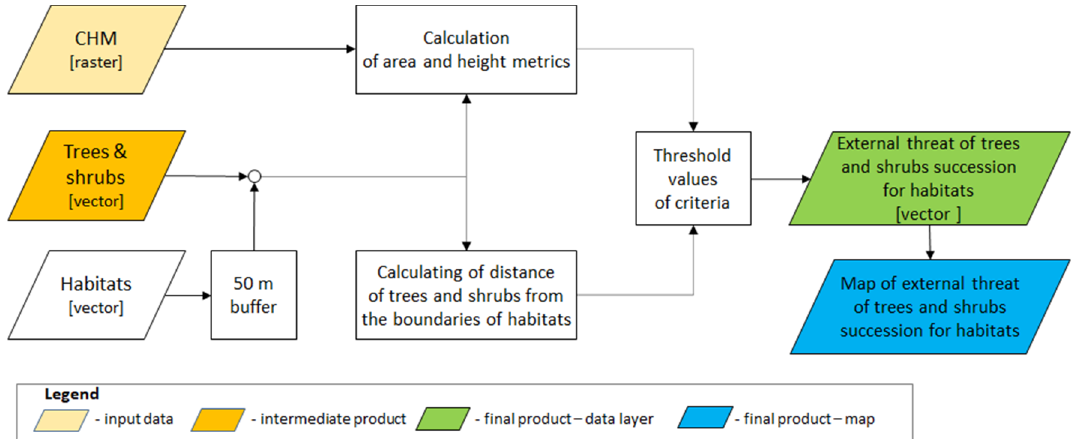
Figure 6. Scheme of the assessment of the level of external threat for a habitat from the succession process.